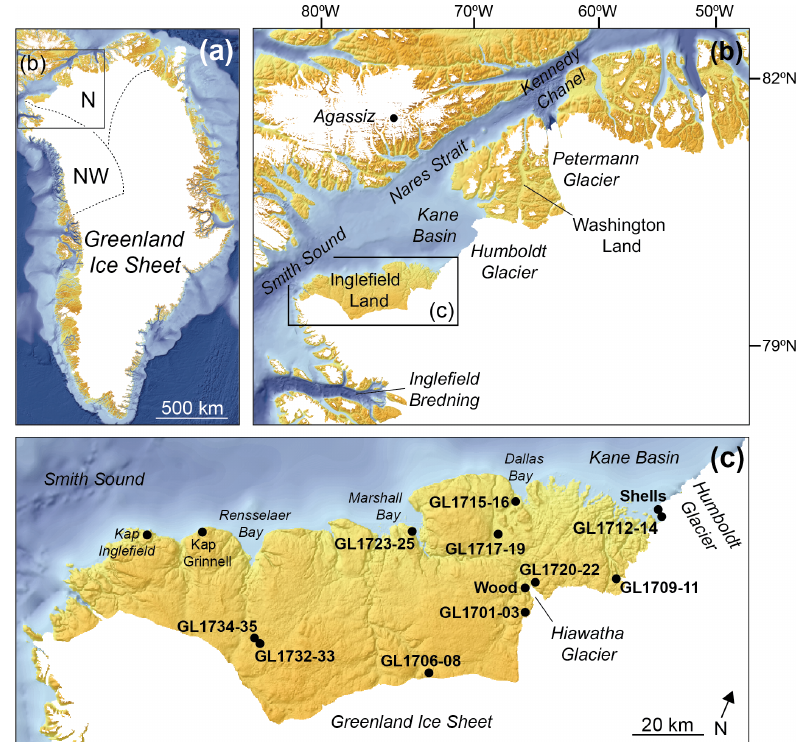
Figure 1. Location of the study area in Greenland (a) , with marked northwest (NW) and north (N) Greenland extent and places mentioned in the text (b) . Panel (c) shows Inglefield Land with places discussed in the text. Black dots denote sample locations for wood fragments in front of the Hiawatha Glacier, molluscs at the margin of the Humboldt Glacier and boulder samples (GL17XX) collected throughout the study